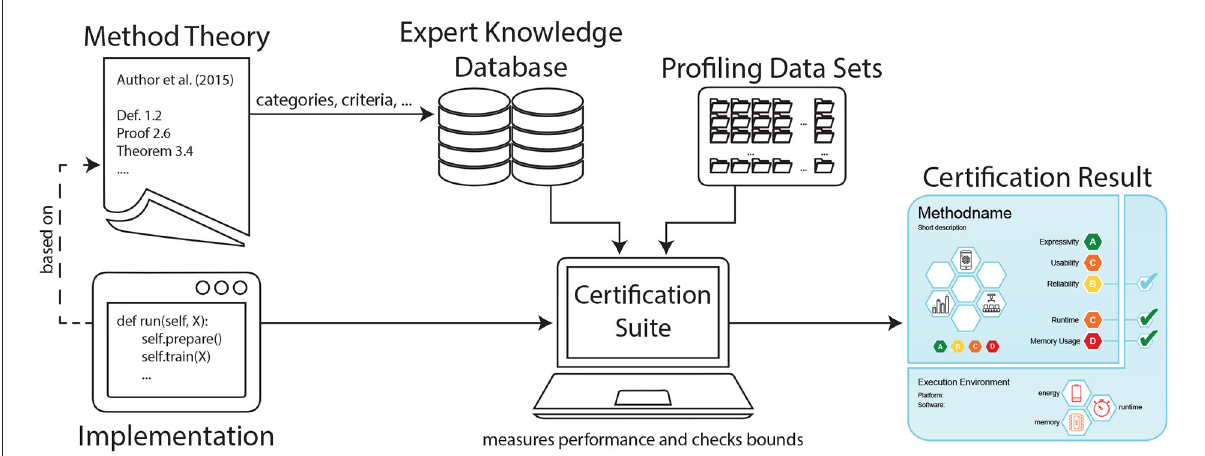
FIGURE1 Proposed framework for certifying machine learning methods with care labels . For a given implementation, the certification suite generates a label that informs both on aspects of underlying theory (fetched from the expert knowledge database) as well as practical